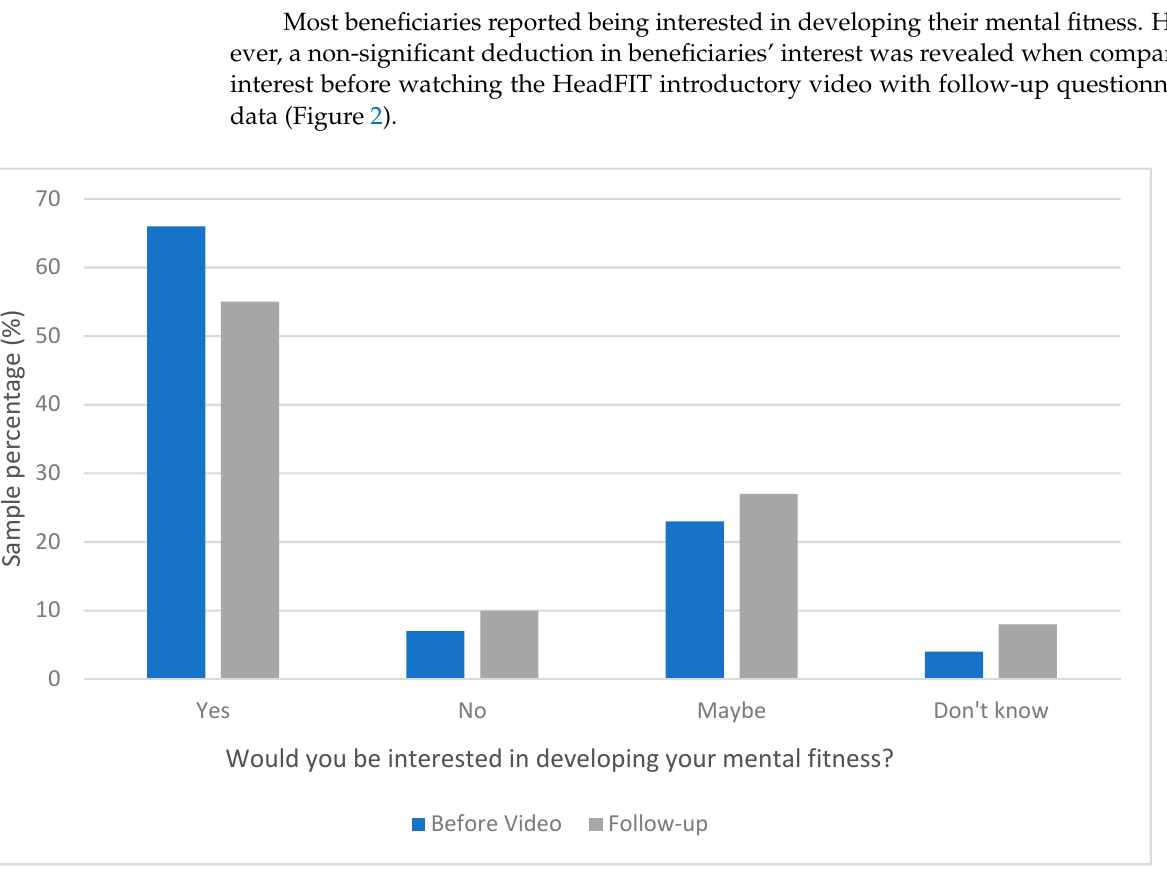
Table 2. Beneficiaries’ Definitions of Mental Fitness Comparing BV to Follow Up.